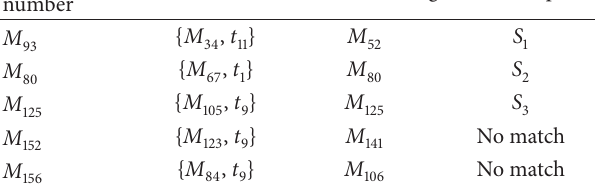
Table 8: The relation between type II CMTSIs and selective siphons. Dead marking